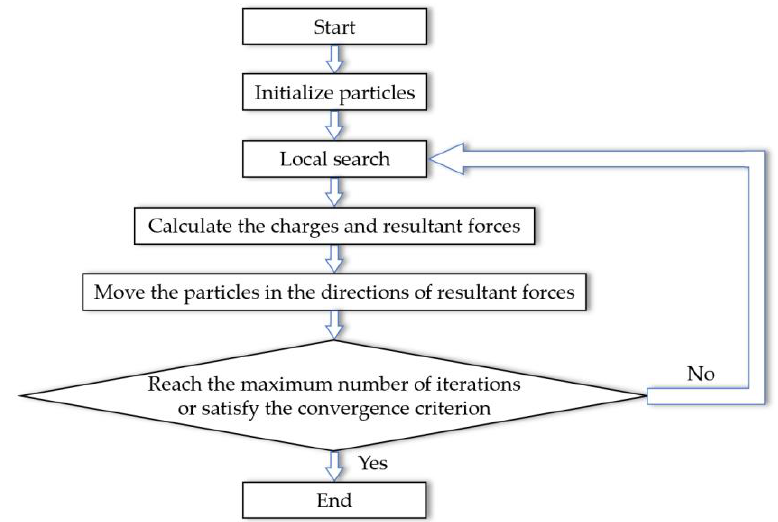
Figure 2. Flowchart of the original electromagnetism-like mechanism (EM) algorithm.